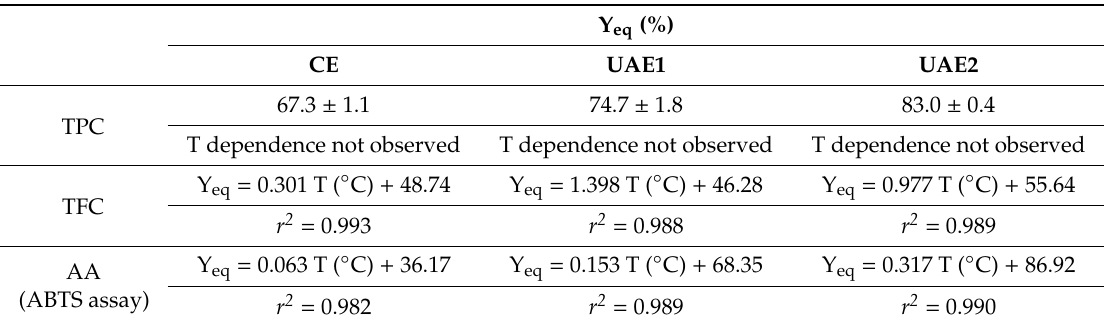
Table 2. Equilibrium extraction yields (Y eq , %) of total polyphenol (TPC) and total flavonoid (TFC) contents, and antioxidant activity (AA) (ABTS assay) for mechanical agitation (CE (conventional extraction) at 80 rpm) and acoustically assisted (UAE1 at 520 W / L; UAE2 at 790 W / L) extraction and their observed temperature dependence within the temperature range 5–25 ◦ C. Y eq (%) CE UAE1 UAE2 67.3 ± 1.1 74.7 ±